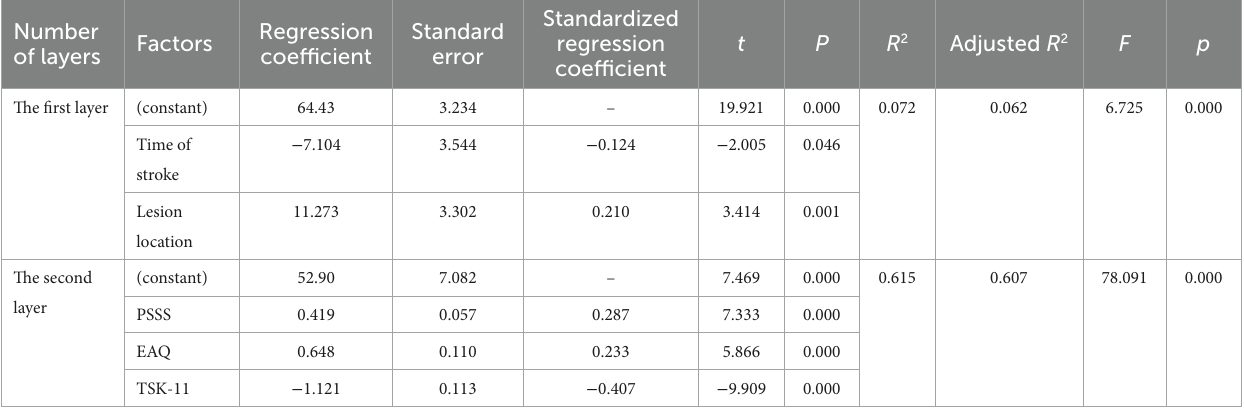
TABLE 4 Results of linear regression analysis of factors associated with MORE in older adult patients with stroke. Number of